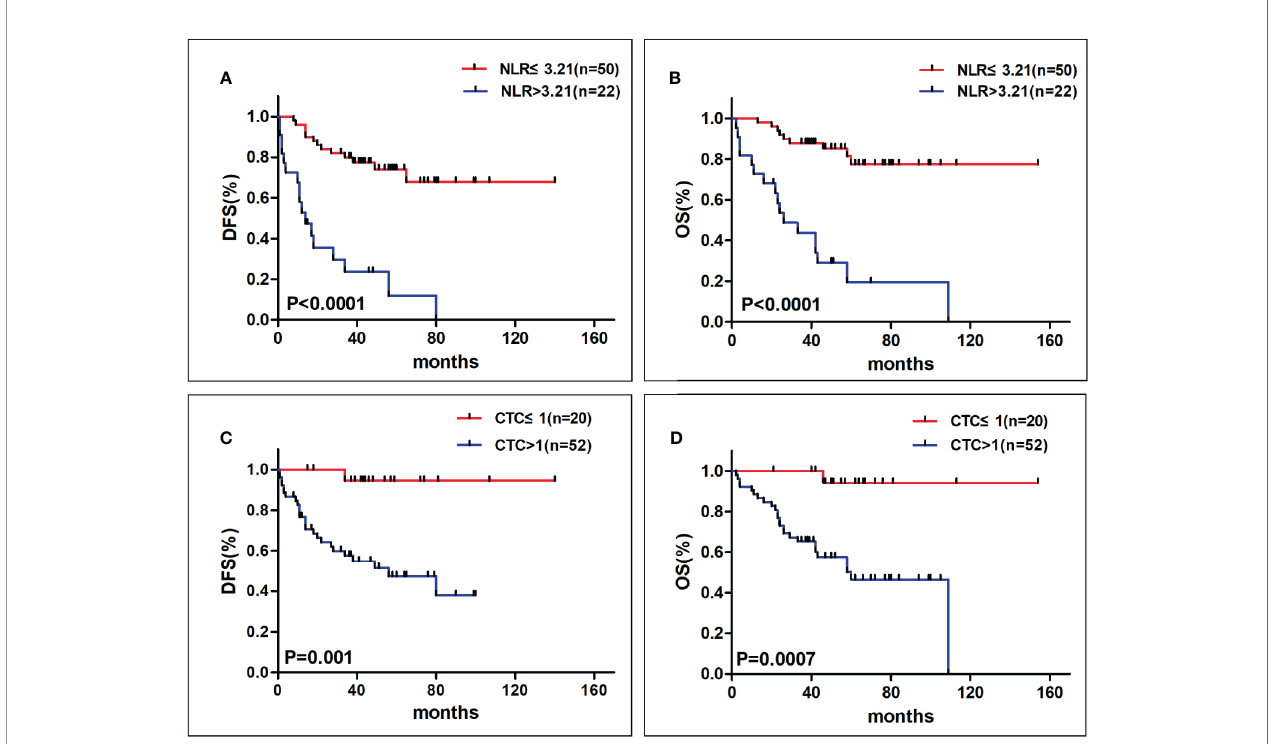
FIGURE 1 | The Kaplan – Meier analysis curves for NLR on DFS (A) and OS (B) and for CTCs on DFS (C) and OS (D) (DFS, disease-free survival; OS, overall survival; NLR, neutrophil – lymphocyte ratio; CTCs, circulating tumor cells). Patients in higher NLR group had poorer prognosis with shorter DFS and OS, meanwhile, patients with more CTCs tended to have worse clinical outcome with shorter DFS and OS.